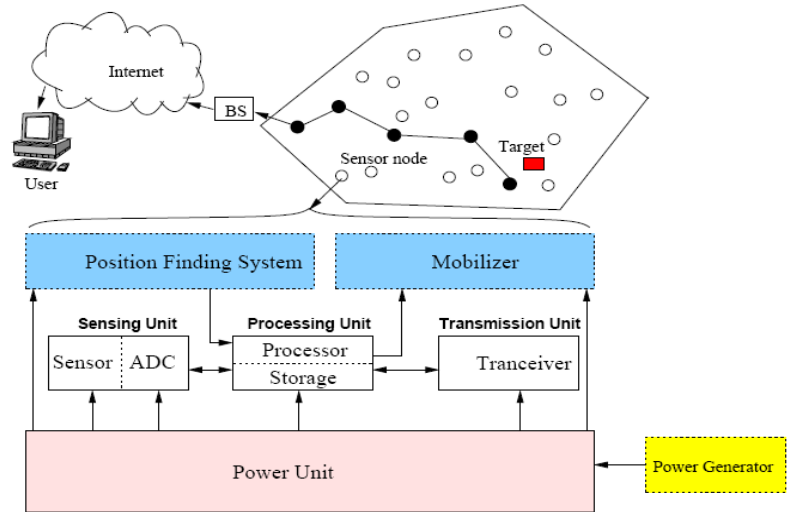
Figure 3. The main sensor node structure